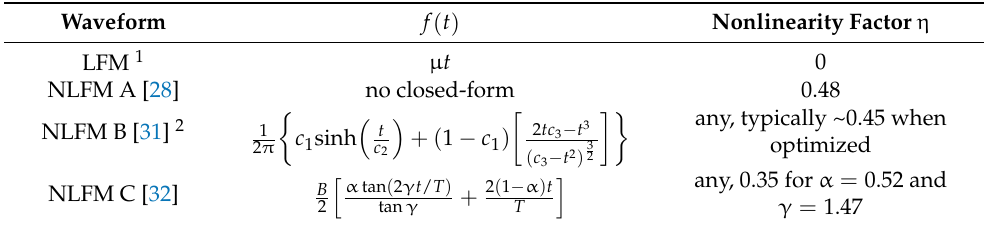
Table 1. Considered radar